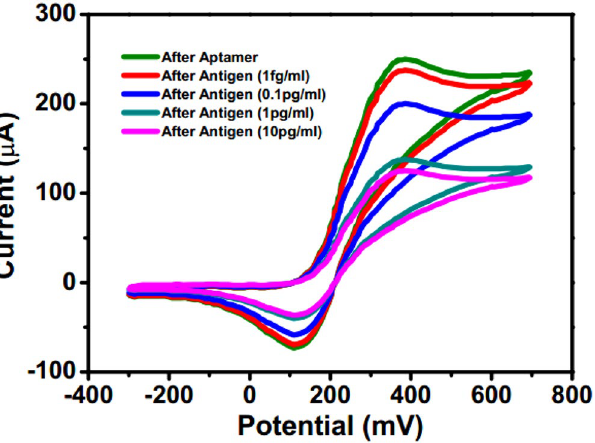
Figure 1. Cyclic voltammetry in absence of external electric field after aptamer and antigen binding (graph indicates mean values with maximum standard deviations of ±